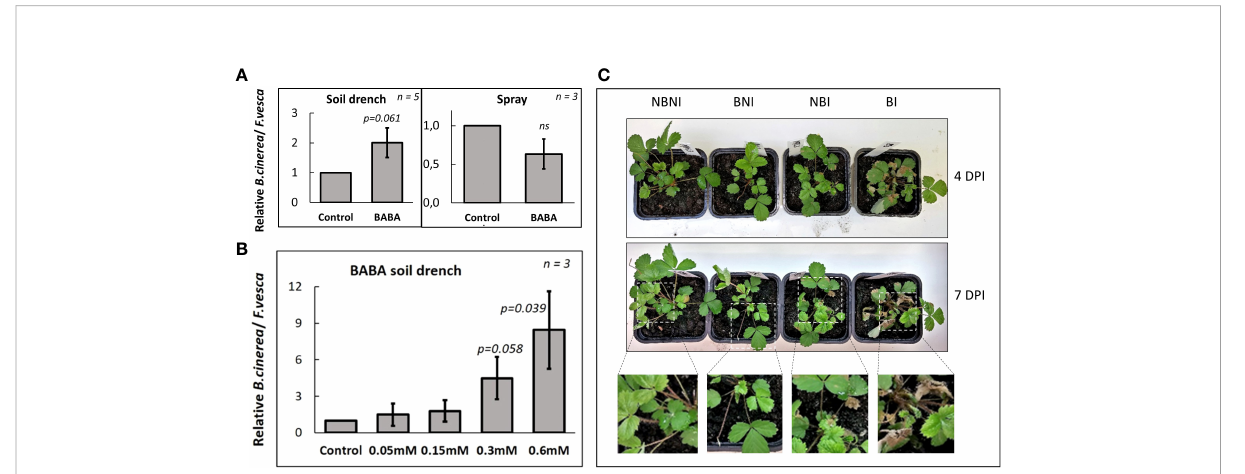
FIGURE 1 Effects of BABA on Fragaria vesca resistance to Botrytis cinerea infection of leaves. (A) B. cinerea infection 5 days post-inoculation in leaves of F. vesca plants after soil-drenching (left) with 0.2 mM b -aminobutyric acid (BABA) or foliar spraying with 0.3 mM BABA (right), or (B) soil-drenching with 0 mM, 0.05 mM, 0.15 mM, 0.3 mM or 0.6 mM BABA two days before inoculation. Levels of B. cinerea infection was measured as the ratio between B. cinerea and F. vesca DNA using qPCR with genome-speci fi c primers for B. cinerea (Bc3F and Bc3R) and F. vesca (EF1 a F and EF1 a R). Levels of B. cinerea in untreated control plants are set to 1. ‘ n ’ = number of biological replicates (i.e. individual plants), and error bars show standard error ( ± 1 SE). P-values report comparisons between control plants and plants subjected BABA using Student ’ s t-test. ‘ ns ’ = not statistically signi fi cant. (C) Representative pictures of disease progression in F. vesca plants 4 days and 7 days after inoculation, n = 5. Treatment combinations: B. cinerea -infected (NBI; No-BABA and Infected), mock-infected (NBNI; No-BABA and Non-Infected), BABA-treated and B. cinerea -infected (BI; BABA and Infected), and BABA-treated and mock-infected (BNI; BABA and